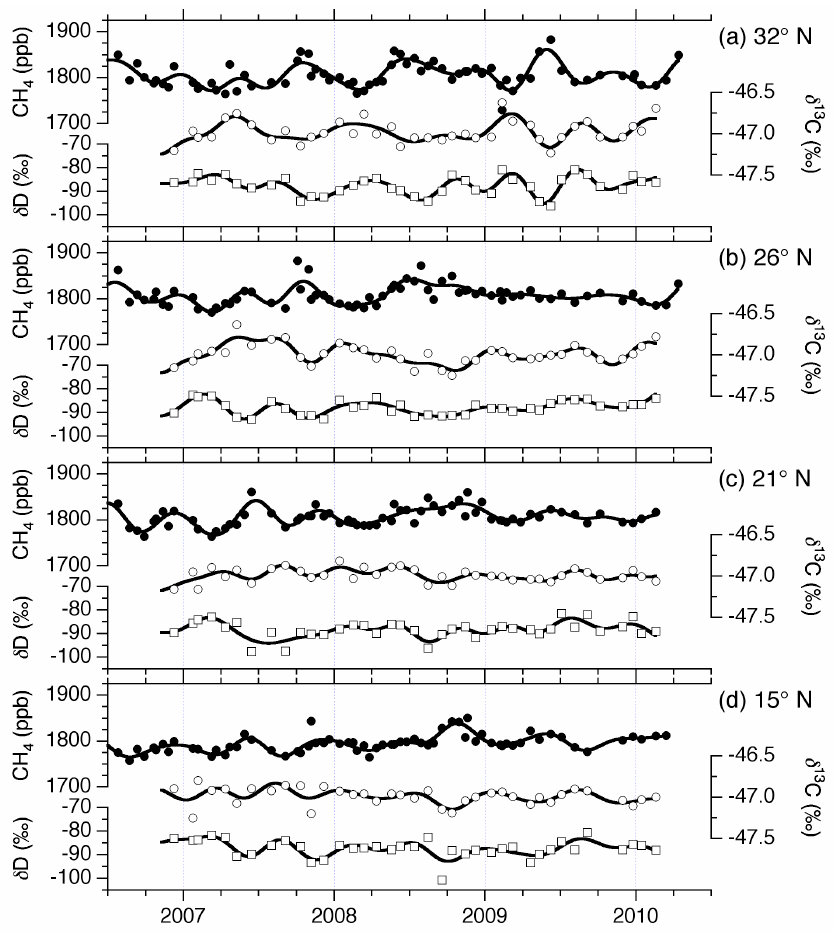
Fig. 2. Temporal variations of the CH 4 mixing ratio (closed circles), δ 13 C (open circles) and δ D (open squares) in the UT at (a) 32 ◦ N, (b) 26 ◦ N, (c) 21 ◦ N and (d) 15 ◦ N in the UT between Australia and Japan and between Japan and Guam. Also shown are the best-fit curves to the observed data (solid lines).